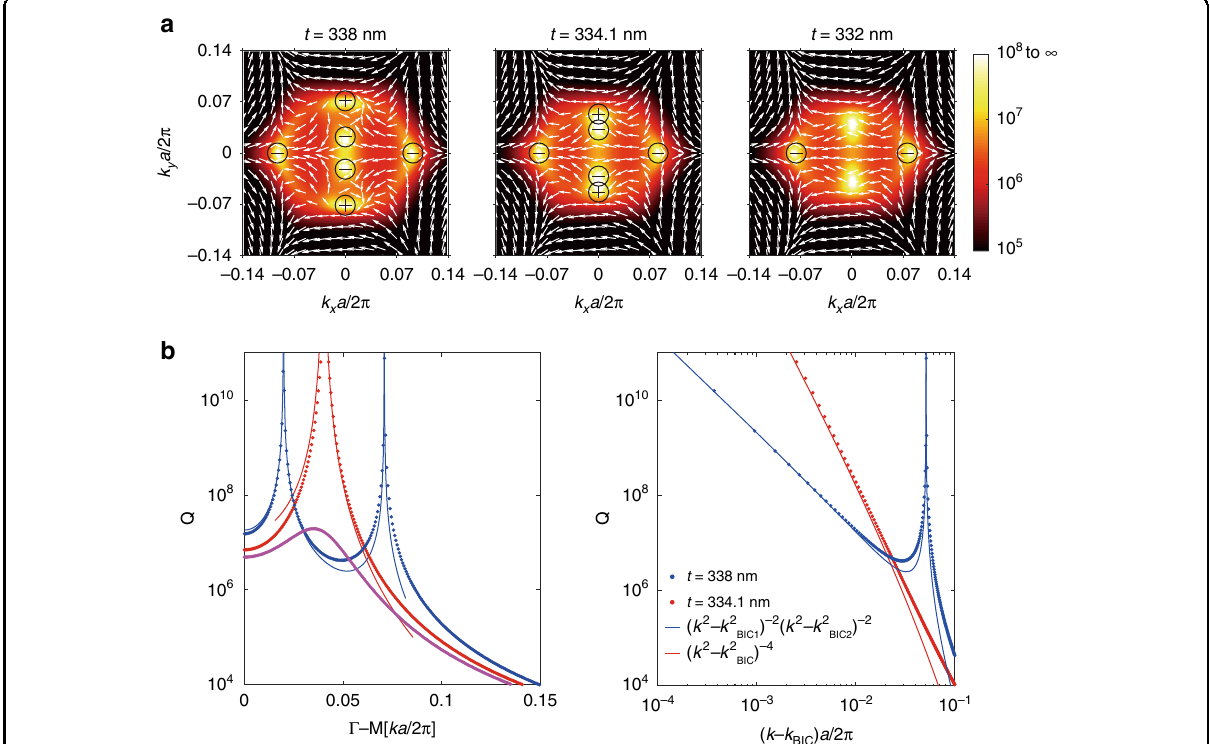
Fig. 3 Merging accidental BICs and the split BICs at off- Γ points. a Simulated polarization vectors around BICs with Q factors as background at different thicknesses. When t is tuned from 338 nm to 332 nm, accidental BICs and the split BICs with opposite topological charges annihilate each other. The transition ( t = 334.1 nm) corresponds to a merging BIC. b Simulated Q factors (dotted lines) and fi tting curves (solid lines). The merging BIC case has considerably enhanced Q factors for nearby states compared with the isolated BICs case. In these simulations, we consider the same system as shown in Fig. 2a and only vary